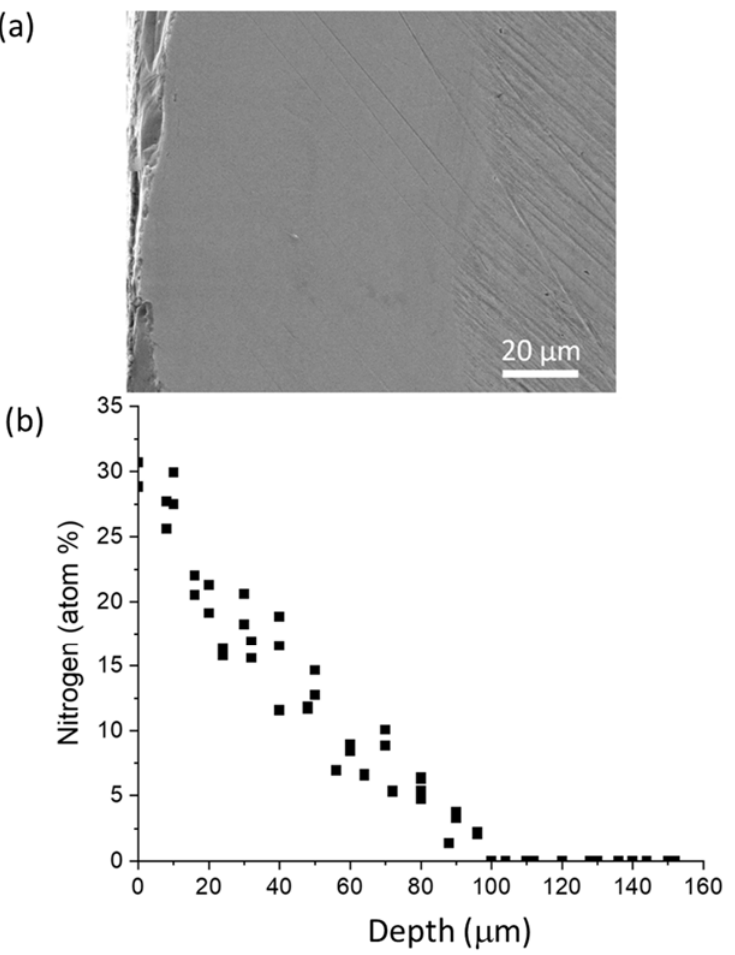
Figure 8. ( a ) SEM image of the polished cross section of Zircaloy-4 after nitridation at 800 °C for 24 h, and ( b ) the corresponding nitrogen profile obtained from cross-sectional WDS.